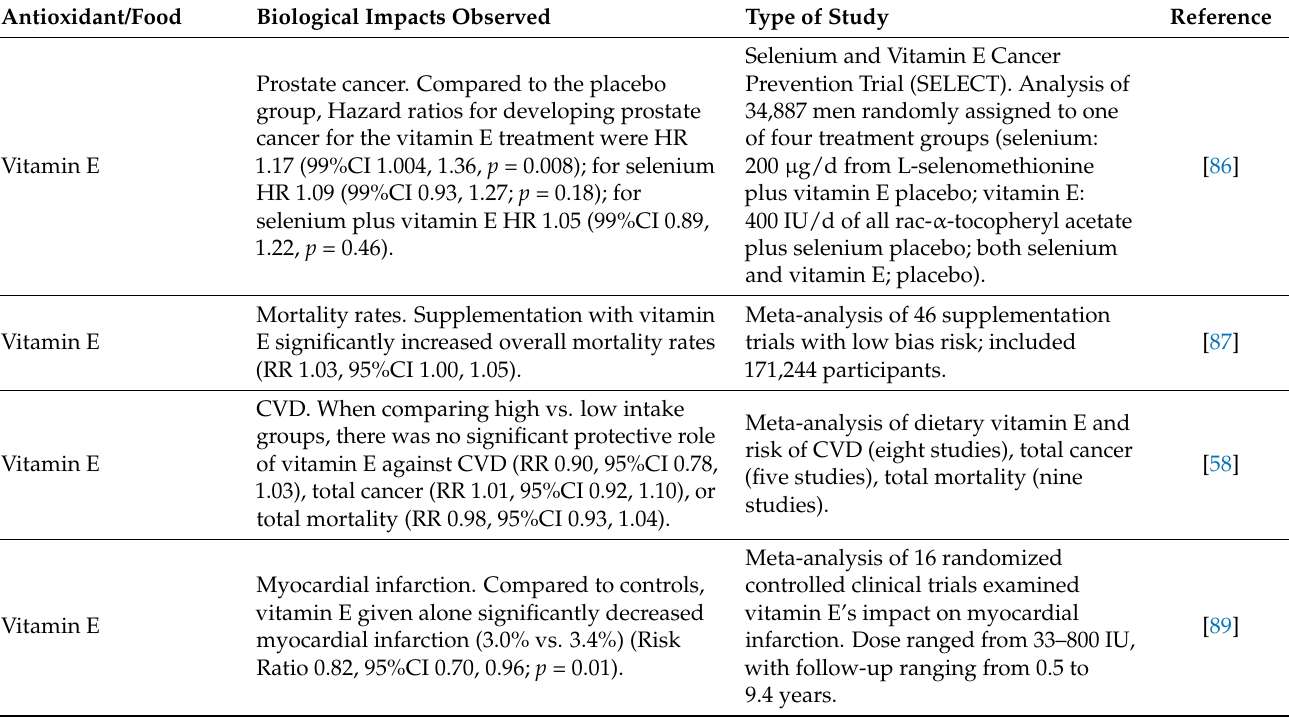
Table 2. Parameters and pertinent results from cited studies examining health outcomes associated with vitamin E. RR = Relative risk, HR = Hazard risk, CVD = cardiovascular